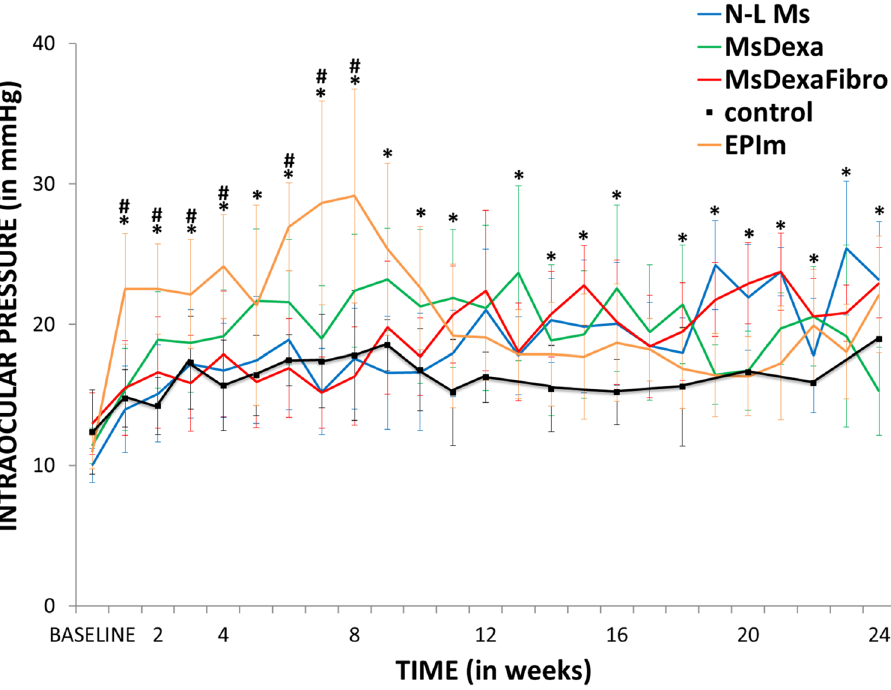
Figure 3. Comparison of intraocular pressure curves in different chronic glaucoma models. N-L Ms : cohort with non-loaded microspheres; MsDexa : cohort with microspheres loaded with dexamethasone; MsDexaFibro : cohort with microspheres loaded with dexamethasone and fibronectin; EPIm : cohort with sclerosis of the episcleral veins. *: statistical significance ( p < 0.05) between glaucoma models and healthy controls (ANOVA); #: statistical significance between the episcleral vein sclerosis model and each microsphere model by Scheffé test. Note that at later times, differences were found between EPIm and some of the microsphere models, (data not shown). Differences were only included when found between the EPIm model and each of the microsphere models. As can be seen, this occurred only at earlier